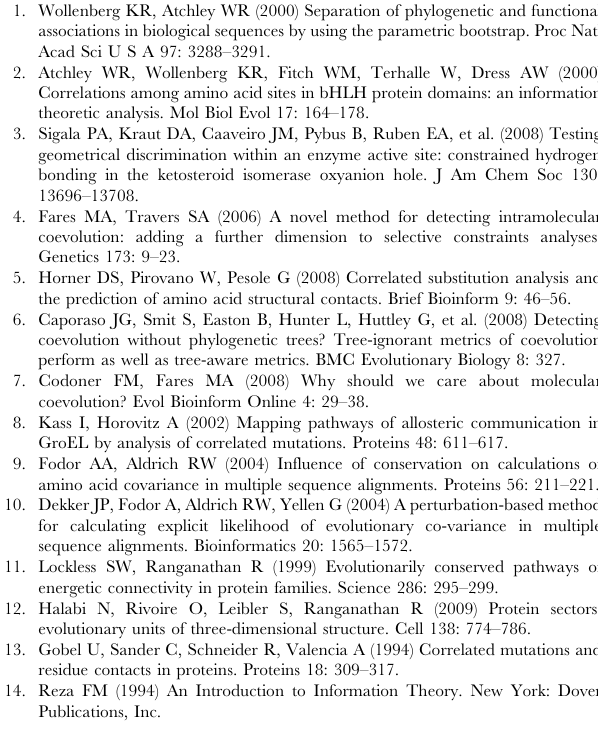
positions (green circles) that are set to coevolve in the simulated MSAs with a group of corresponding positions (red circles). The fifth panel in the lower rows shows the relative entropy of the simulated MSAs (red trace) superimposed to that of the experimental MSA. Figure S11 MSAvolve flowchart. LEVEL 1 : the simulation starts with 3 identical copies of the ancestor (only the first 9 residues of the ancestor are shown). Each copy is subjected to cycles of mutations (dashed orange arrows) and recombination (green crosses). The height of the crosses reflects which sequences undergo recombination. LEVEL 2 : the tree is expanded by adding two copies of each of the 3 sequences of level 1 to the MSA matrix, which now contains 9 rows and 3 different sequences derived from a single ancestral protein. LEVEL 3 : 4 copies of each of the 9 sequences of level 2 are added to the MSA matrix, which now contains 45 rows and 9 different sequences (3 for each of the original 3 branches of the tree) derived from a single ancestral protein. Only the 3 rd branch of the tree is shown for level 3. Thin blue arrows highlight steps that can be repeated as desired in both level 2 and